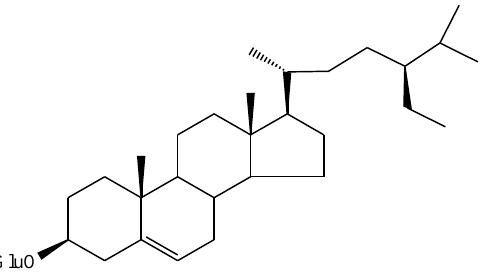
Figure 3. Chemical structure of β-sitosterol-glucoside from the InE